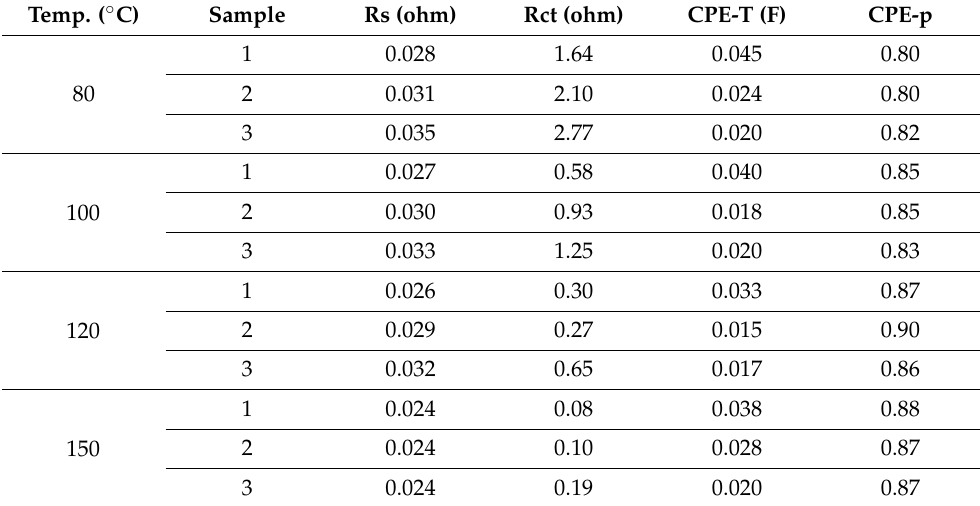
Figure 3. EIS properties at different operating temperatures for samples 1–3: ( a ) 80, ( b ) 100, ( c ) 120, ( d ) 150 °C. Table 3. Parameters obtained from EIS data (Figure 3) fitted to the equivalent circuit shown in Figure